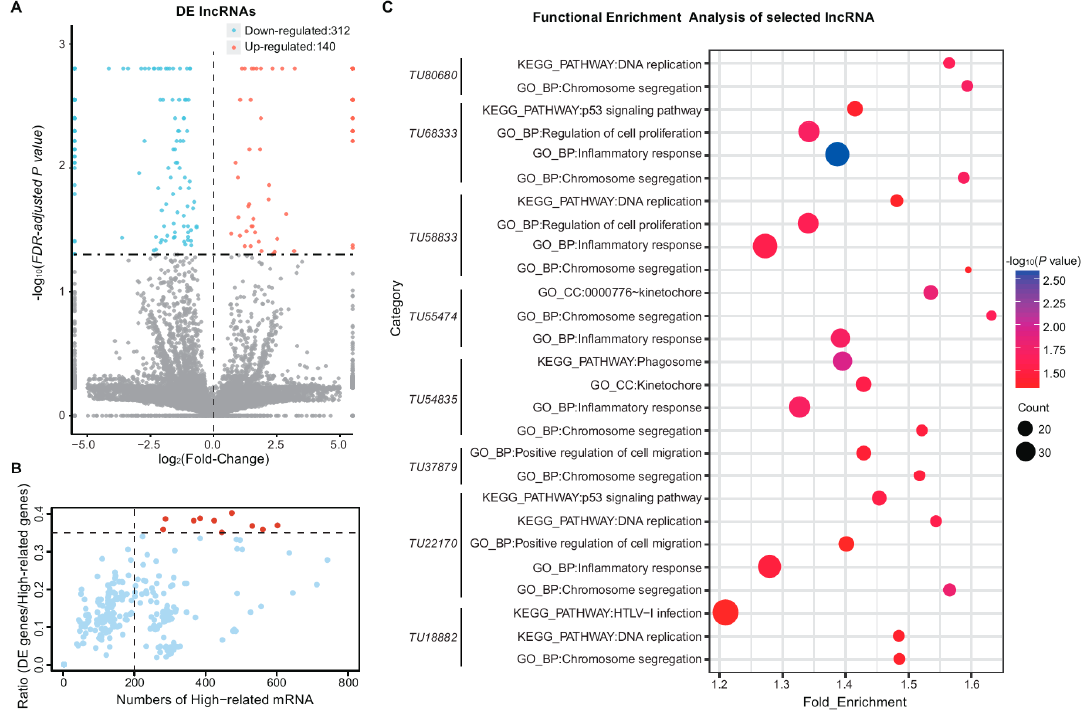
Figure 3. DE lncRNAs revealed the changes in the lung after birth. ( A ) DE lncRNAs with q value ≤ 0.05: 312 were down-regulated, 140 were up-regulated; ( B ) DE lncRNAs distribution based on the ratio of DE genes per highly-related genes and the total highly-related mRNA number. Highly related genes were identified by comparison between mRNAs and lncRNAs as described in methods. A total of 136 lncRNAs had more than 200 related genes and only 10 lncRNAs (marked in red) with a ratio (DE genes per highly-related genes) ≥ 0.35; ( C ) Functional enrichment analysis of the top ten lncRNAs in ( B ) with their related genes, the highly related DE genes were used as gene list while the highly related genes were set as background. Categories ( p value < 0.05) related to cell proliferation and immune response were listed.